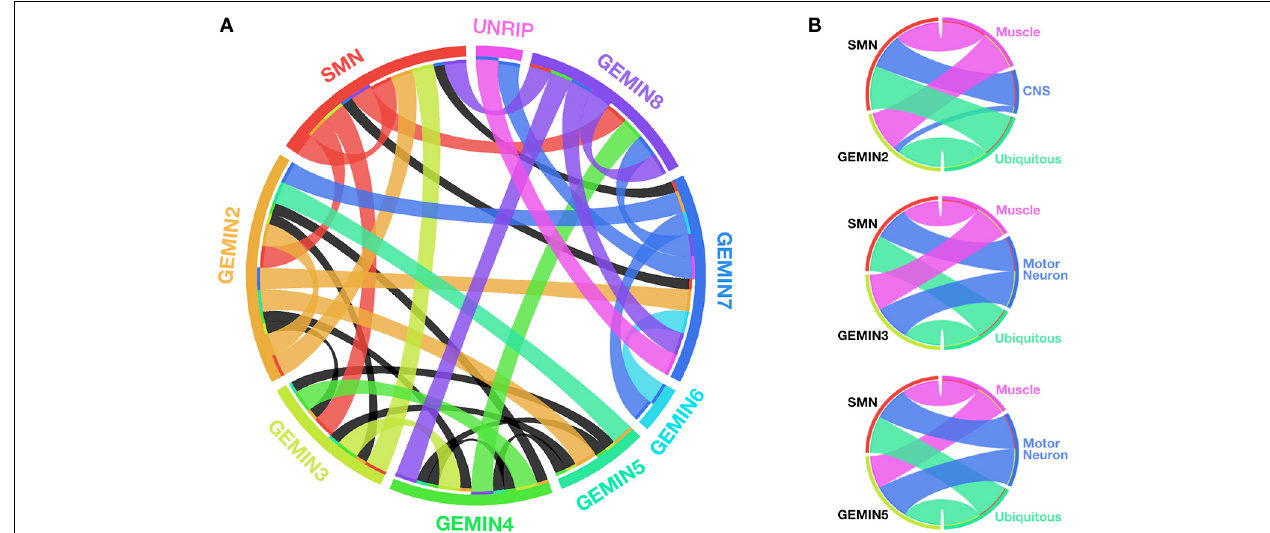
FIGURE 1 | SMN and GEMINs: protein interactions and motor system requirements. (A) Circular representation of the intricate web of interactions between members of the SMN-GEMINs complex in vertebrates. Ribbons shown in colors specific to each complex member indicate interactions verified in more than one experimental system. Black ribbons specify interactions in only one experimental system (based on data reviewed in Cauchi, 2010). (B) Degree of overlap between specific Gemins and SMN with respect to organismal viability on enhanced RNAi-mediated knockdown